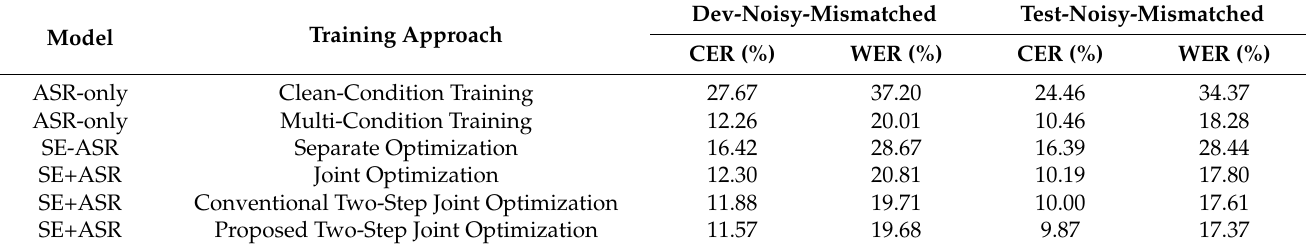
Table 2. Comparison of the average character error rate (CER) and word error rate (WER) of automatic speech recognition (ASR) models trained by various optimization approaches under mismatched noise conditions.